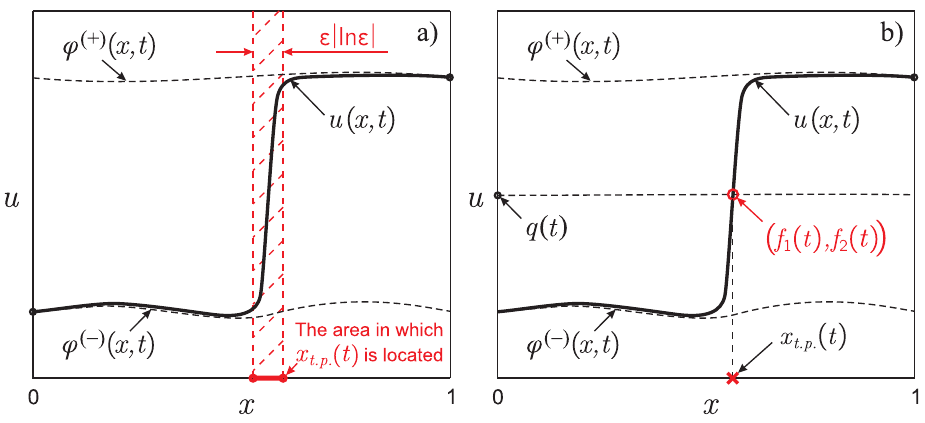
Figure 1. Typical form of a solution of a moving-front-type in Problem (1) at a fixed time t . ( a ) The physical meaning of the value x t . p . ( t ) ; ( b ) the formal definition of the value of x t . p . ( t ) when applying the methods of asymptotic analysis (see Section 2.2) or the gradient method for minimizing the target functional (see Section